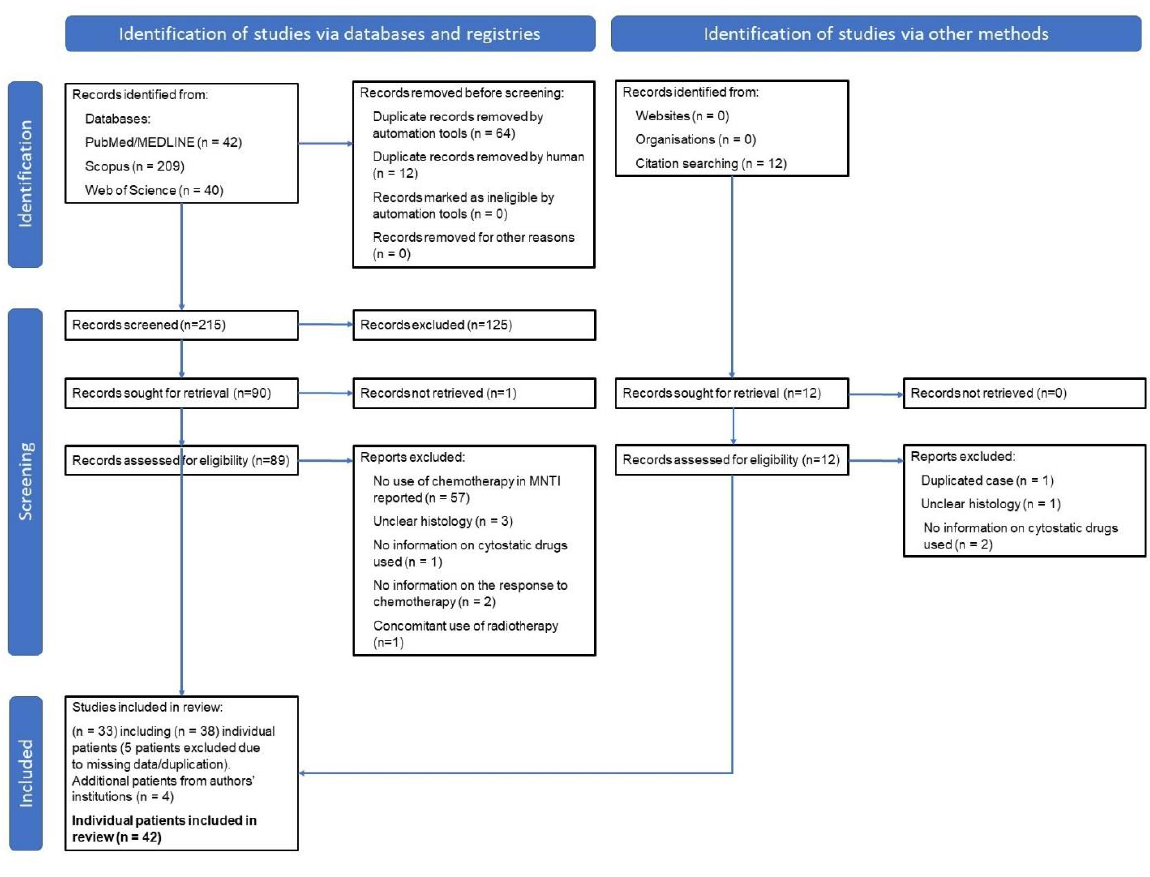
Figure 6. Flowchart of the study selection process (according to PRISMA 2020 guidelines).